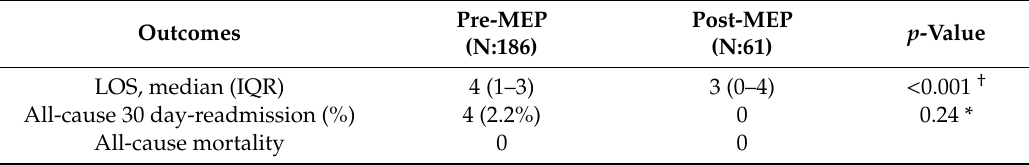
Table 2. Patient